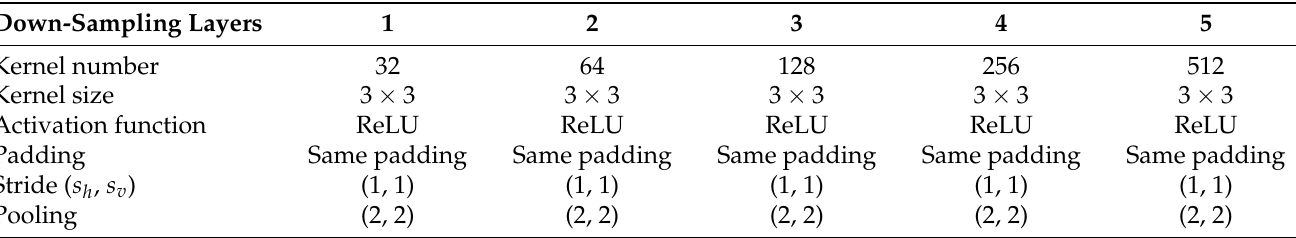
Figure 4. The architecture of the proposed network. Table 1. Specifications of the down-sampling convolution